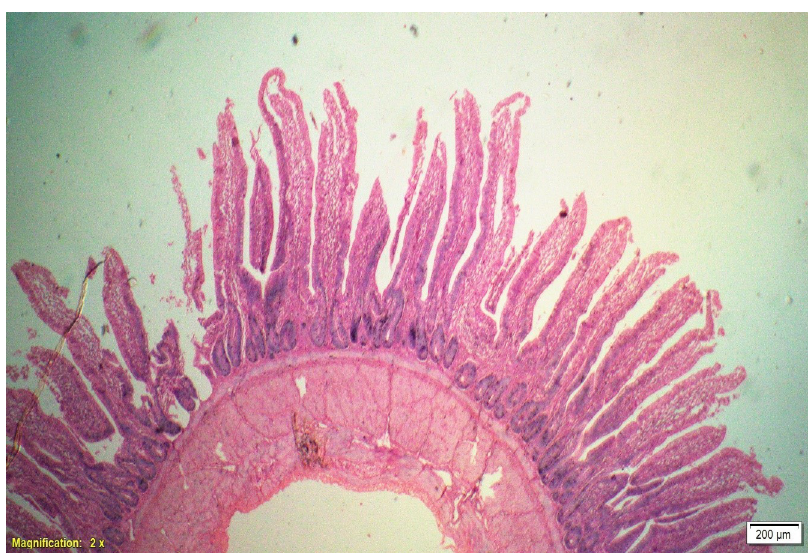
Fig 12. Photomicrograph of the cross section of ileum from probiotic + chicory + coriander group (T6), H&E,